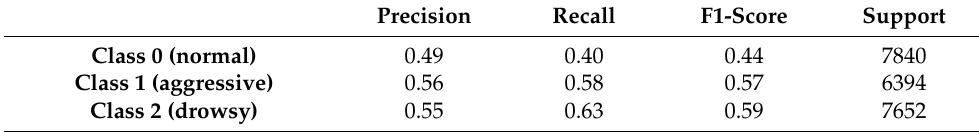
Table 5. Multi-class evaluation metrics with the logistic regression classifier for traffic status.